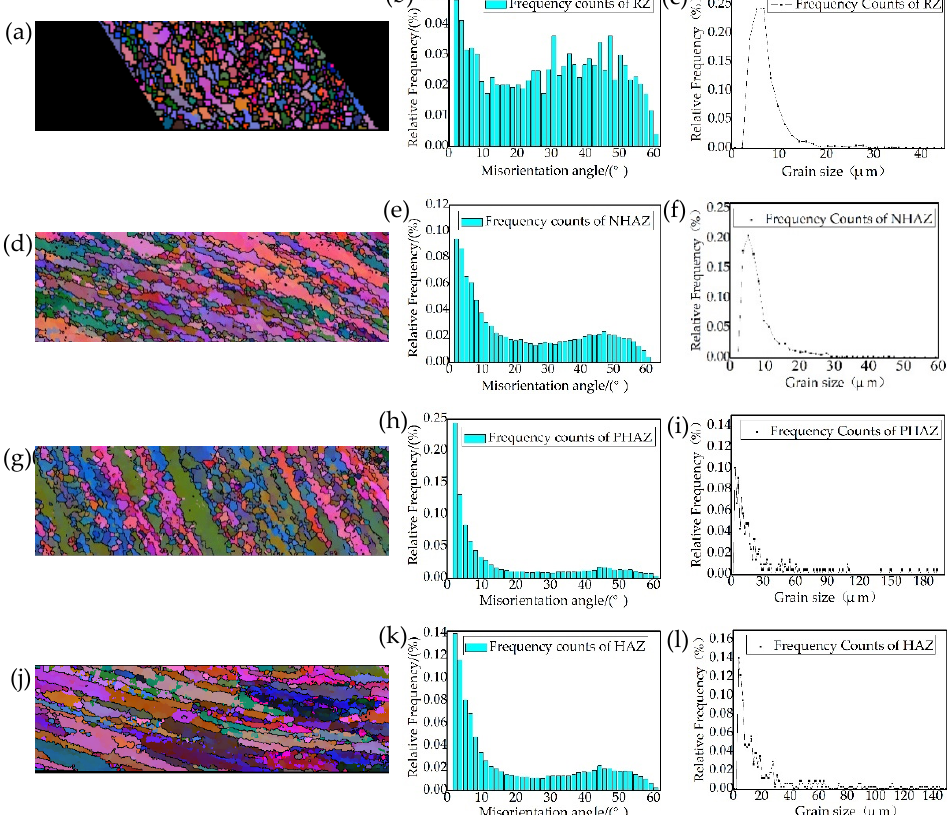
Figure 15. EBSD analysis of FPW joint for FSW weld: ( a ) RZ IPF coloring, ( b ) RZ misorientation angle, ( c ) RZ grain size, ( d ) NHAZ IPF coloring ( e ) NHAZ misorientation angle ( f ) NHAZ grain